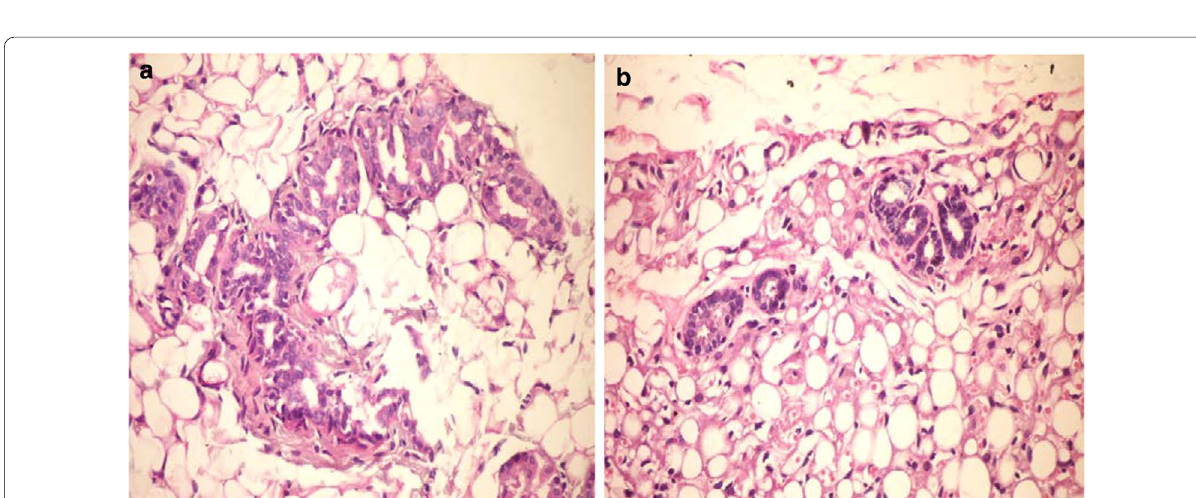
Fig. 2 a , b Mammary gland of rat showing normal acini with cuboidal cell lining (H&E